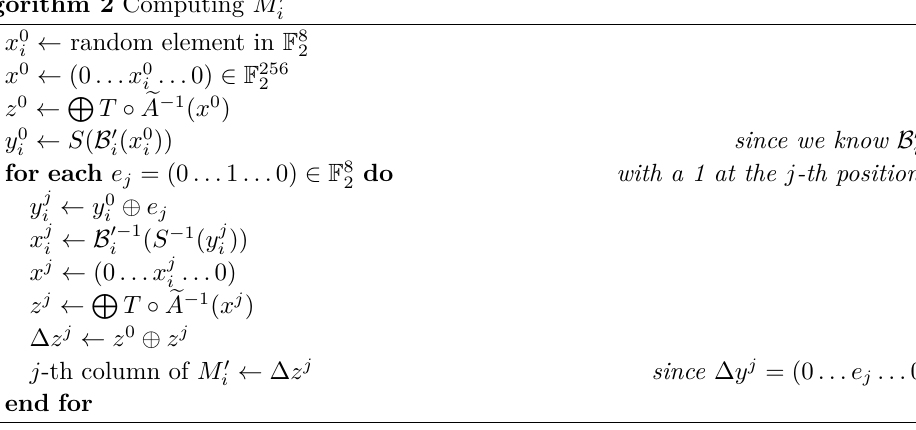
Algorithm 2 Computing M 0